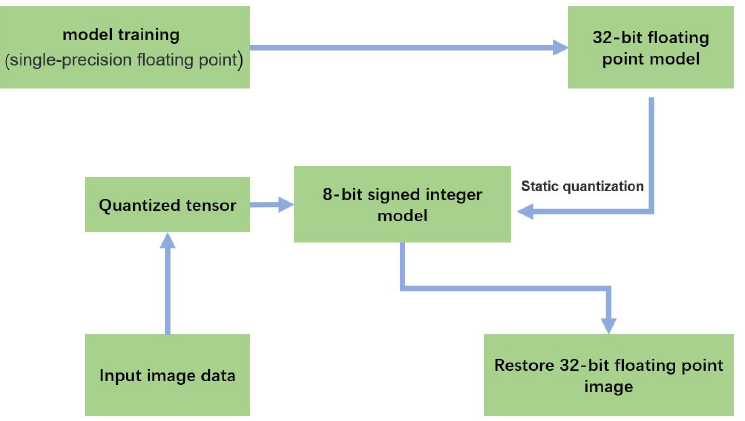
Figure 4. The static quantization process of the model.